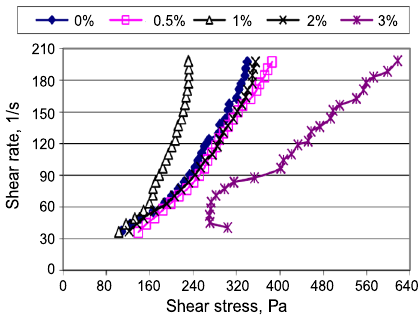
Fig. 7. Cement paste with CEM II R cement shear stress vs shear rate after 150 min